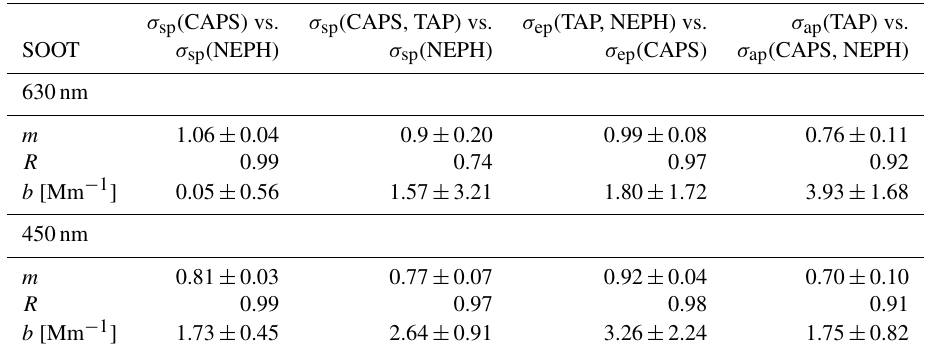
Table 8. Linear regression results of scattering ( σ sp ), extinction ( σ ep ) and absorption ( σ ap ) coefficients for external mixtures of SOOT and AS particles, given as slopes ( m ), Pearson R and y axis intercepts ( b ). σ sp (CAPS) vs. σ sp (CAPS, TAP) vs. σ ep (TAP, NEPH) vs. σ ap (TAP) vs. SOOT σ sp (NEPH) σ sp (NEPH) σ ep